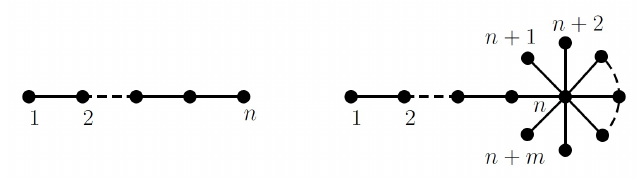
Figure 1. Path P n and Broom B n + m